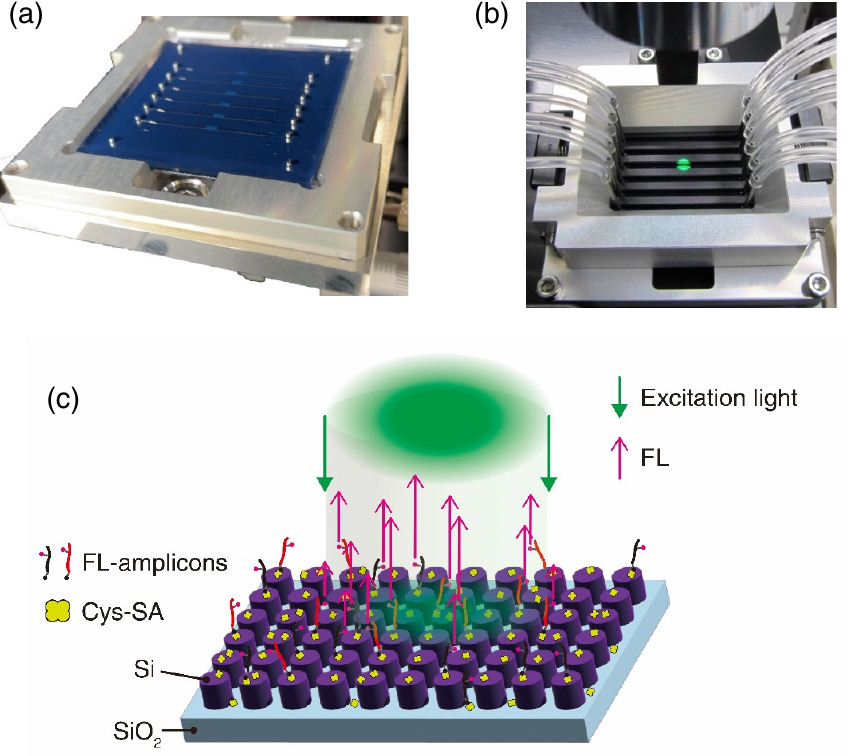
Figure 2. Metasurface biosensors. ( a ) Photograph. ( b ) The metasurface biosensor holder. Tubes are connected. Green spot is focused LED light for excitation. ( c ) Schematic of immobilized FL-labeled amplicons and FL emission on the all-dielectric